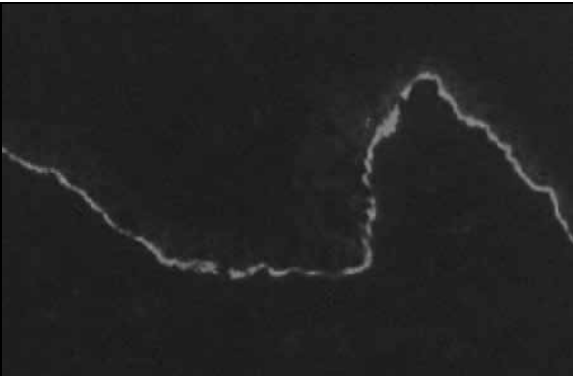
Figura 3 – Imunofluorescência direta. Depósito linear e homogêneo de IgA em ZMB (aumento de